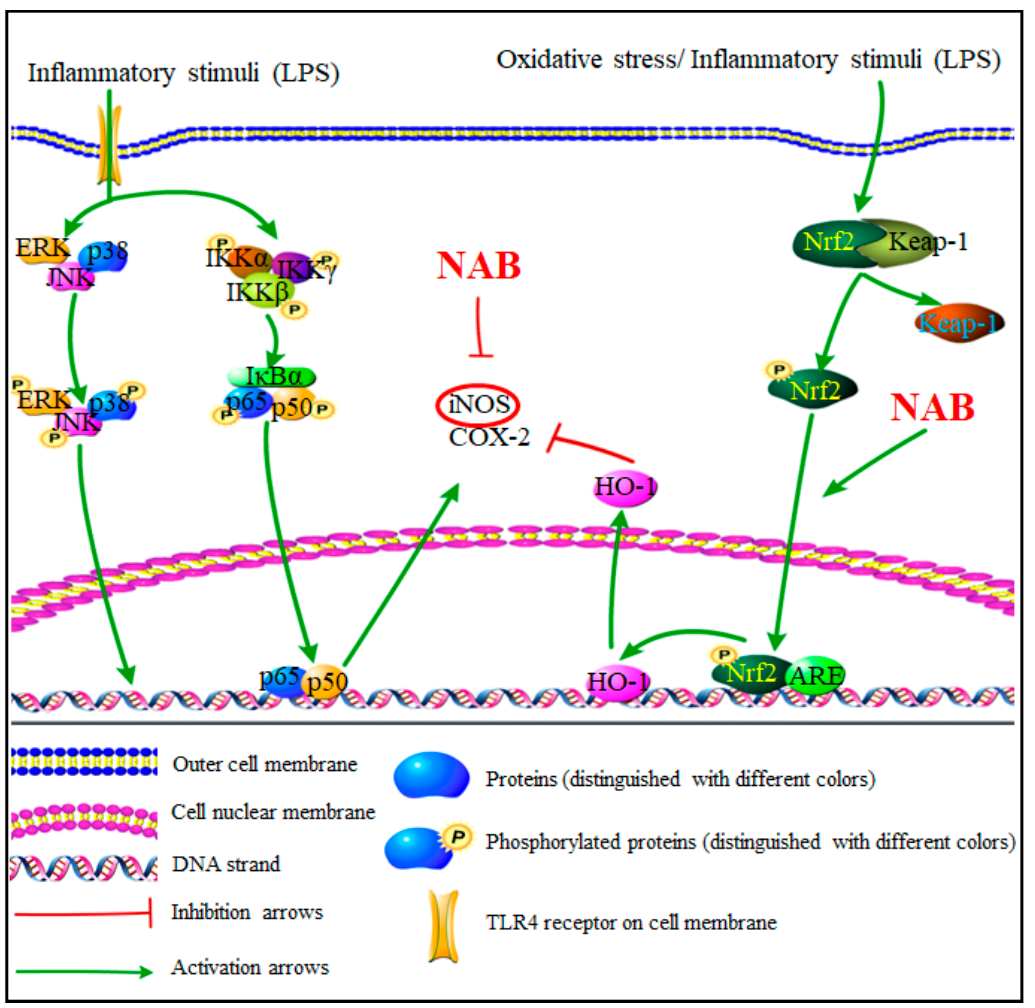
Figure 8. Proposed molecular mechanisms underlying the inhibitory e ff ect of NAB on the LPS-activated RAW264.7 macrophages. NAB activates the Nrf2 pathway, leading to the high expression of HO-1, then contributing to the anti-inflammatory e ff ects in LPS-activated RAW264.7 macrophages. Abbreviations in the figure: NAB, nardochinoid B; TLR4, Toll-like receptors; ERK, extracellular regulated protein kinase; JNK, c-Jun N-terminal kinase; HO-1, heme oxygenase (HO)-1; Nrf2, nuclear factor erythroid 2-related factor 2; Keap-1, Kelch-like ECH-associated protein-1; ARE, antioxidant response element; iNOS, inducible nitric oxide synthase; COX-2, cyclooxygenase-2; IKK α / β / γ , I κ B kinase α / β / γ ; I κ B α , inhibitor of nuclear factor kappa-B kinase α .